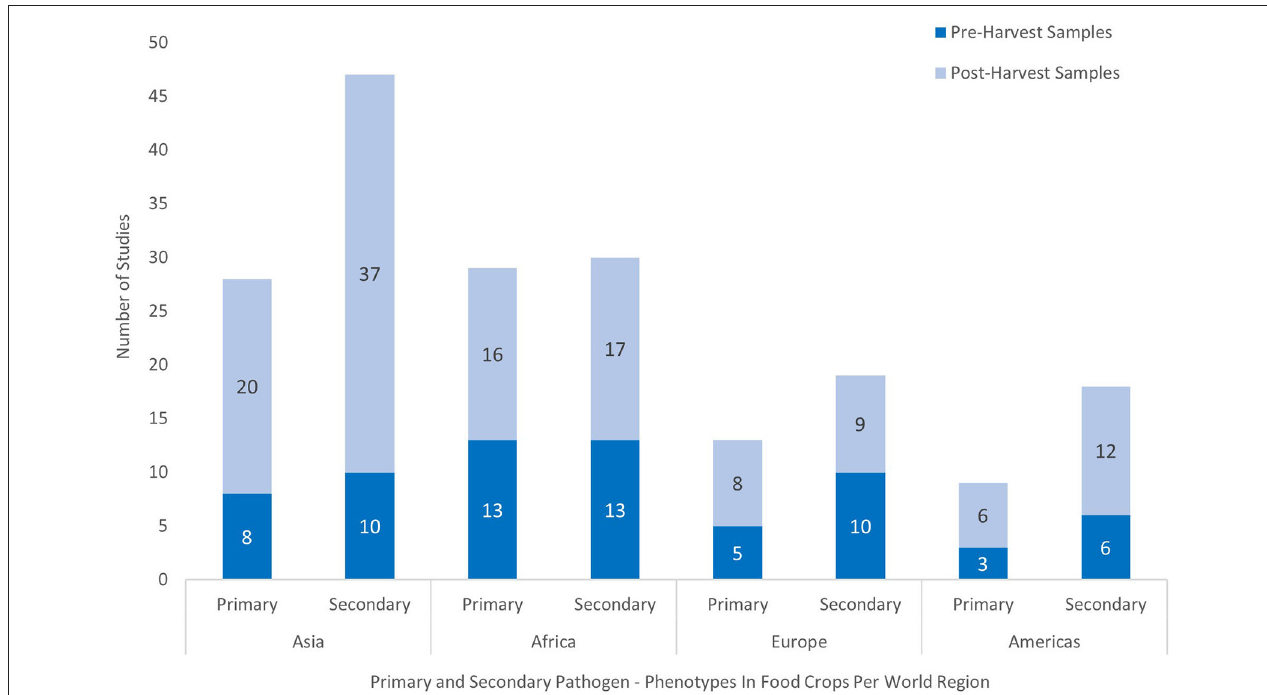
FIGURE 4 | Analysis of the world region origin of occurrence of pathogen-phenotype combinations in studies conducted on the food crop value chain. Selected studies published between 2000 and 2020 are grouped by the stage of sampling at the pre- or post-harvest level of the value chain and by priority level of the pathogen-phenotype